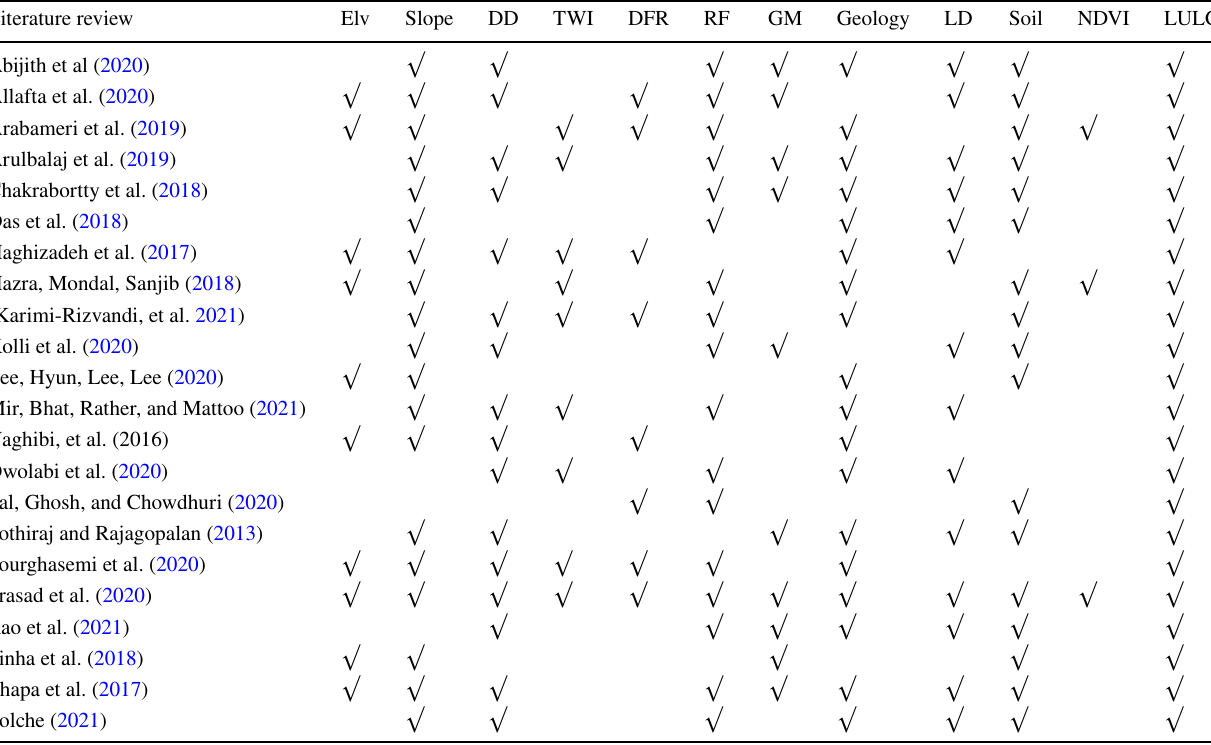
Table 2 Literature review of factors used to delineate groundwater potential zones